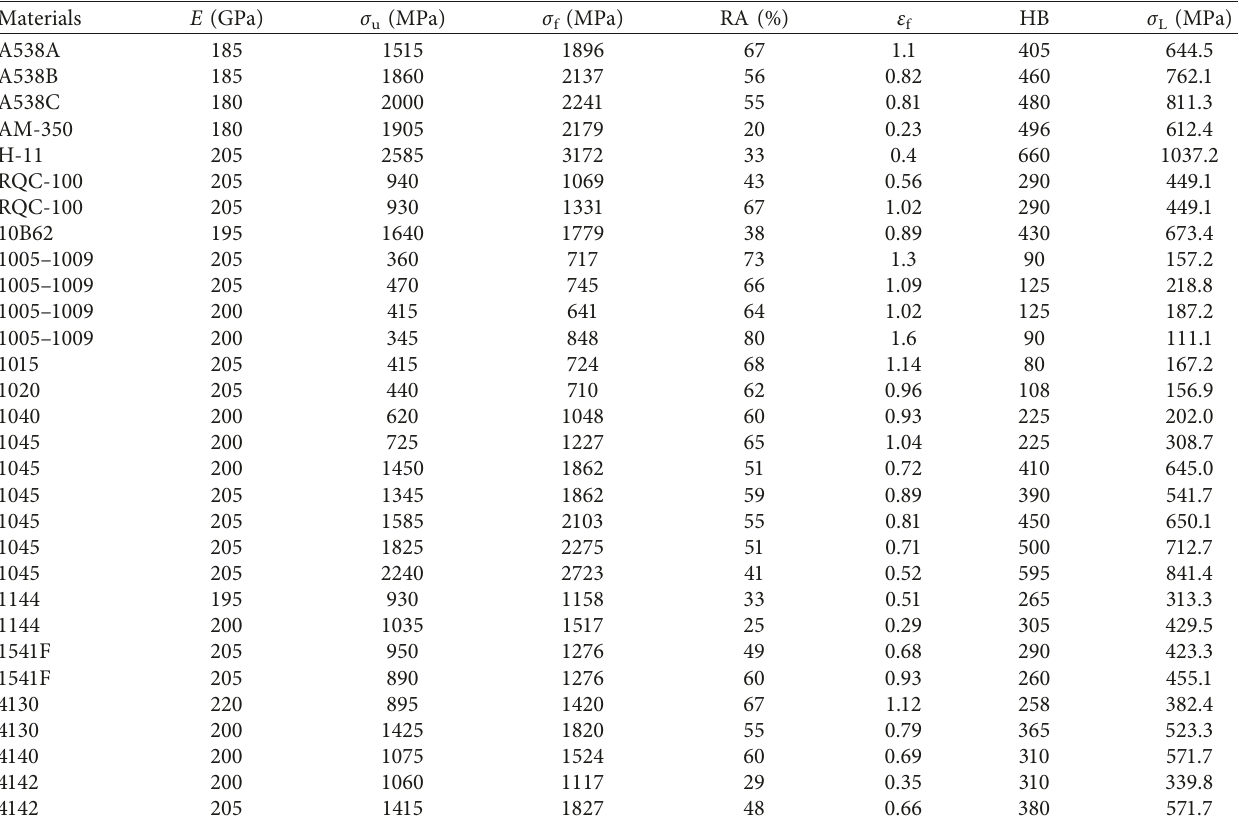
Table 2: Monotonic deformation properties and fatigue limit of the selected steels from the ASM Handbook [7].